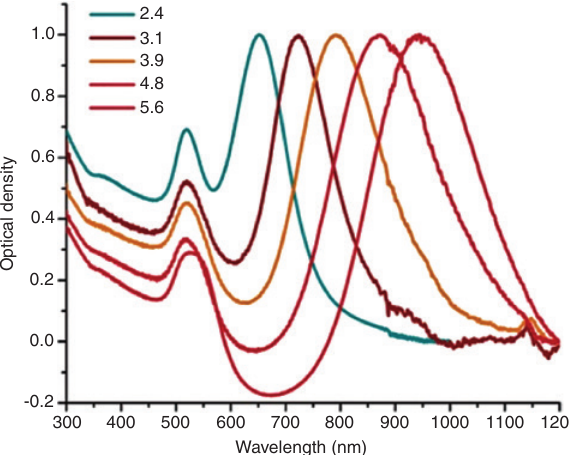
Figure 16: Surface plasmon absorption spectra of gold nanorods of different aspect ratios, showing the sensitivity of the strong lon- gitudinal band to the aspect ratios of the nanorods. Reprinted with permission from [93]. Copyright 2006 American Chemical Society.